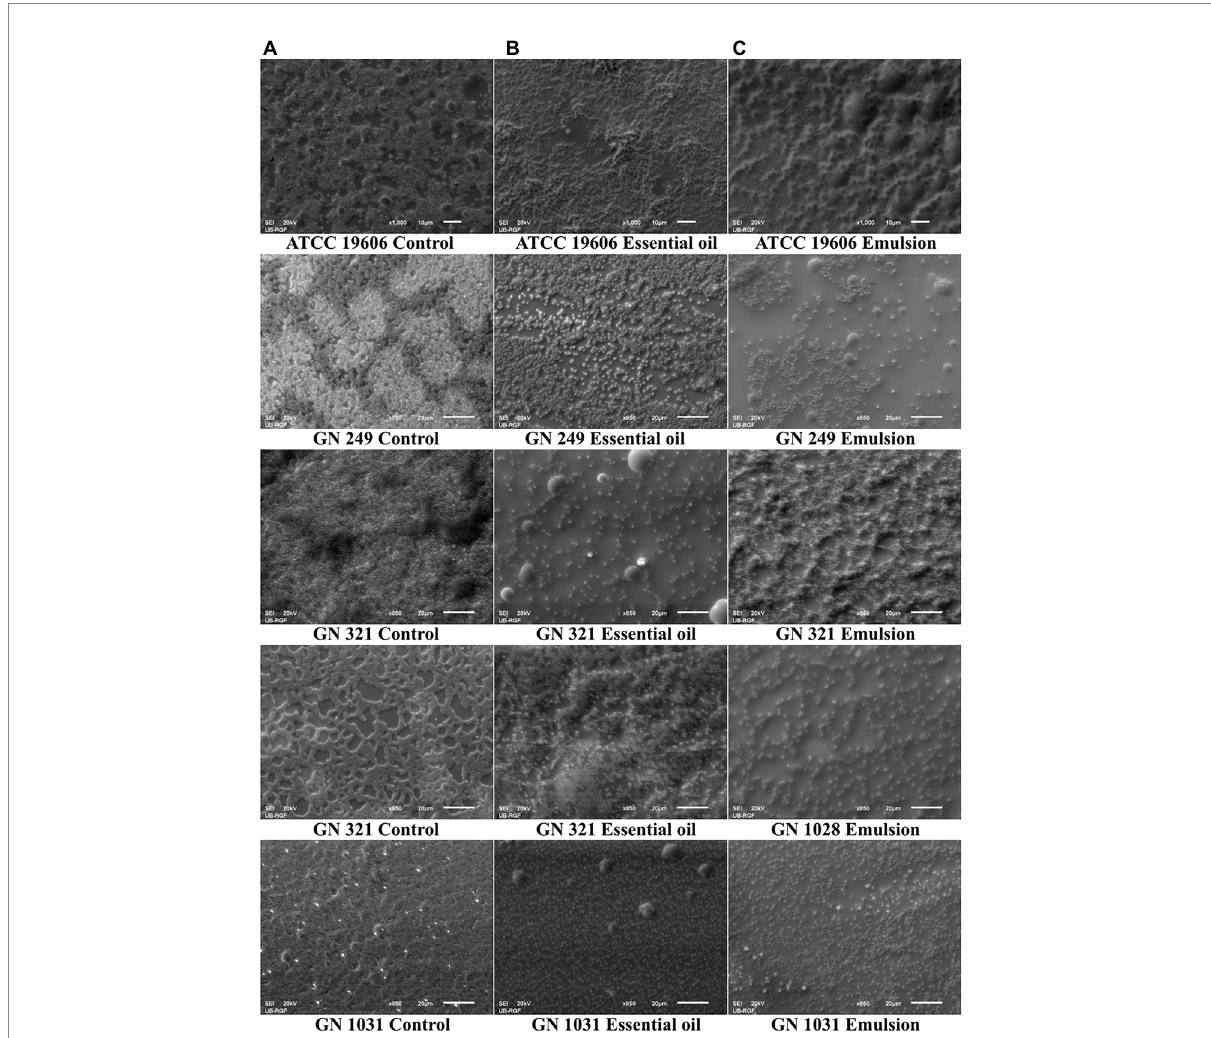
FIGURE 6 Scanning electron microscopy micrographs of Acinetobacter baumannii ATCC 19606 and clinical strains biofilms. On the left side are not treated biofilms used as controls (A) , in the middle are biofilms treated with the cinnamon essential oil (B) , and on the right side are biofilms treated with the cinnamon emulsion (C) . Concentrations used for biofilm treatment with cinnamon essential oil and emulsion was the highest applied concentration used in biofilm dispersal assay. All micrographs are presented with the magnification × 850 or × 1,000, with the scale bars in the down-right corner of the pictures 20 or 10 μ m,